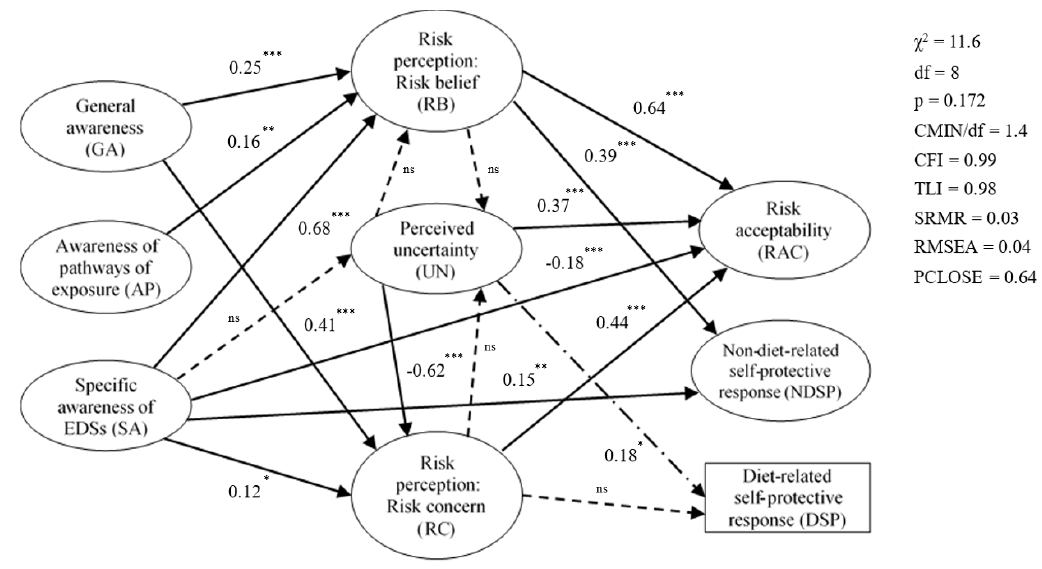
Figure 3. Final model of the determinants of risk perception, risk acceptability, and self-protective response. Notes: Direct effects: thick solid arrows; moderating effects: slim solid and dot lines; indirect effects: combinations of a slim dot line (SA/RB to UN) and a long dash dot line (UN to DSP). * p < 0.05; ** p < 0.01; *** p < 0.001; ns